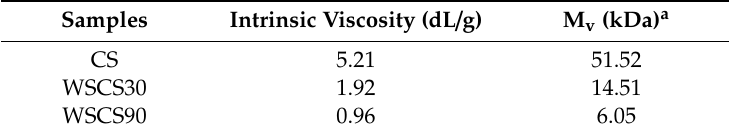
Table 2. Intrinsic viscosity and viscosity-average molecular weight (M v ) of CS, WSCS30, and WSCS90. Samples